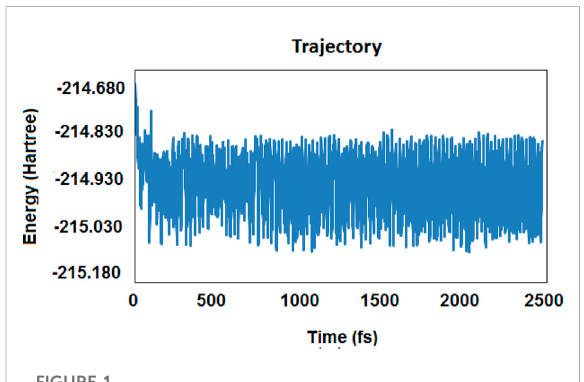
FIGURE 1 Results of the trajectory diagram for the molecular dynamic simulation based on energy per time (in femtosecond)